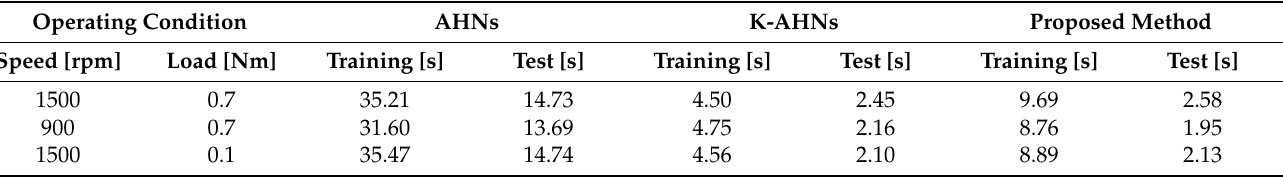
Figure 3. The classification results of the five states of the motor bearing of Paderborn University under three operating conditions ( a ) Rotational speed = 1500 rpm, load torque = 0.7 Nm; ( b ) Rotational speed = 900 rpm, load torque = 0.7 Nm; ( c ) Rotational speed = 1500 rpm, load torque = 0.1 Nm; ( d ) Average classification rate and error degree. Table 1. The average CPU 1 times of the three methods in the training and test